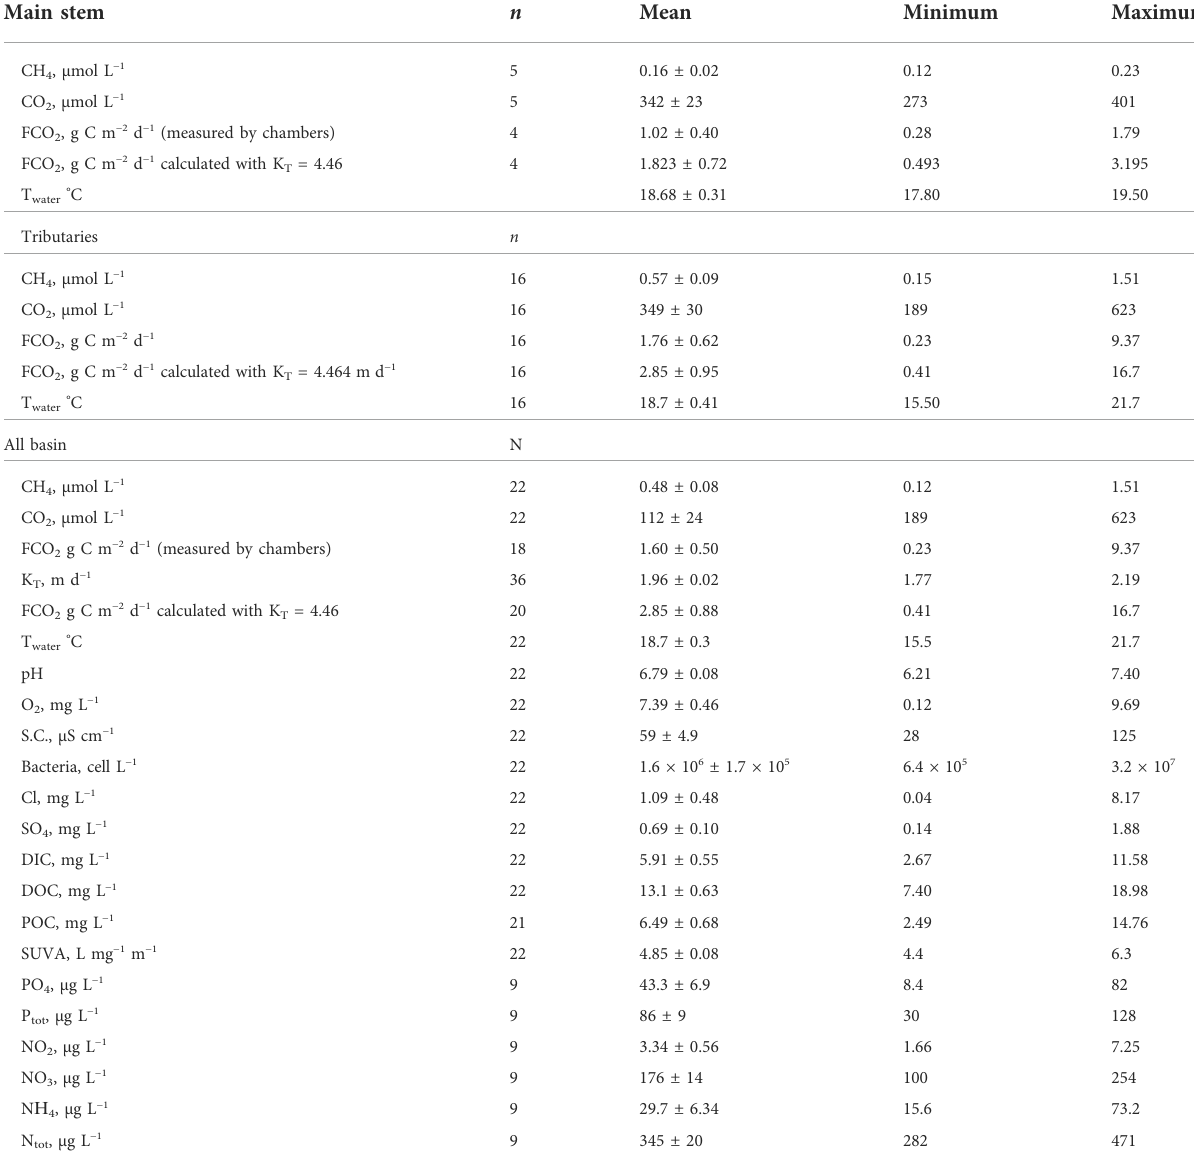
TABLE1Measuredwatertemperature,pCO 2 ,calculatedCO 2 fl ux,CH 4 ,DOC,andDICconcentrations,pHandotherhydrochemicalparametersinthe Taz River main stem and tributaries [mean ± s.d.; (n) is number of measurements]. Main